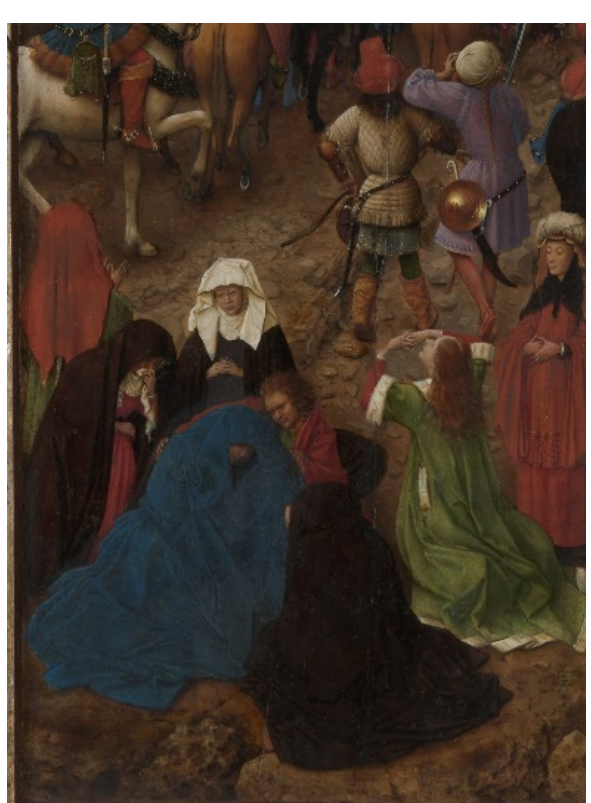
Figure 3. Detail of Figure 1. Shifting to the right panel, the heavenly Christ, who overcame death on the cross, now wears a red mantle and is positioned to give justice on Judgment Day (Figure 4). Situated to the left is the Virgin of Mercy wearing an expansive blue mantle enveloping